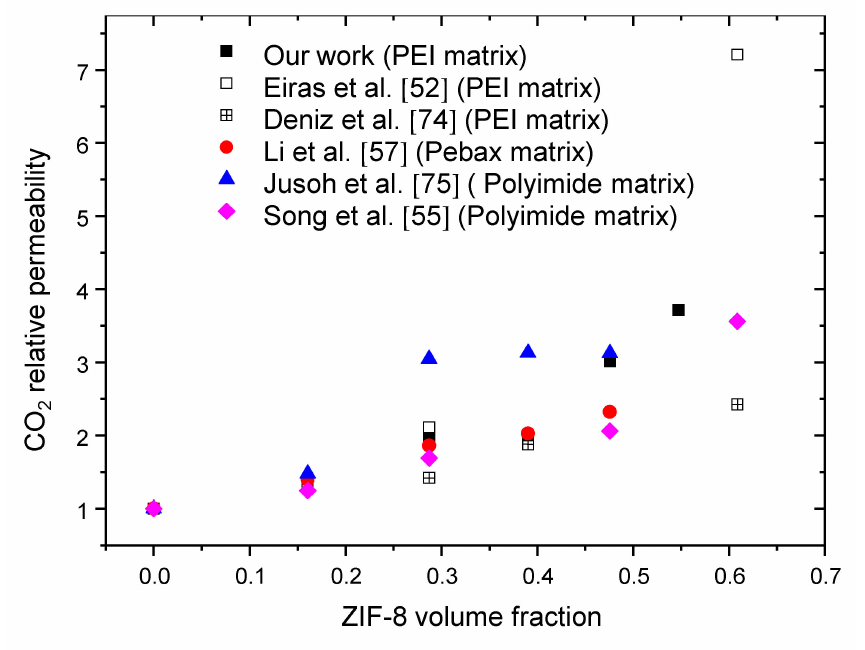
Figure 9. Comparison of our experimental CO 2 relative permeability with data from the literature obtained for several systems based on ZIF-8 and different polymer matrices